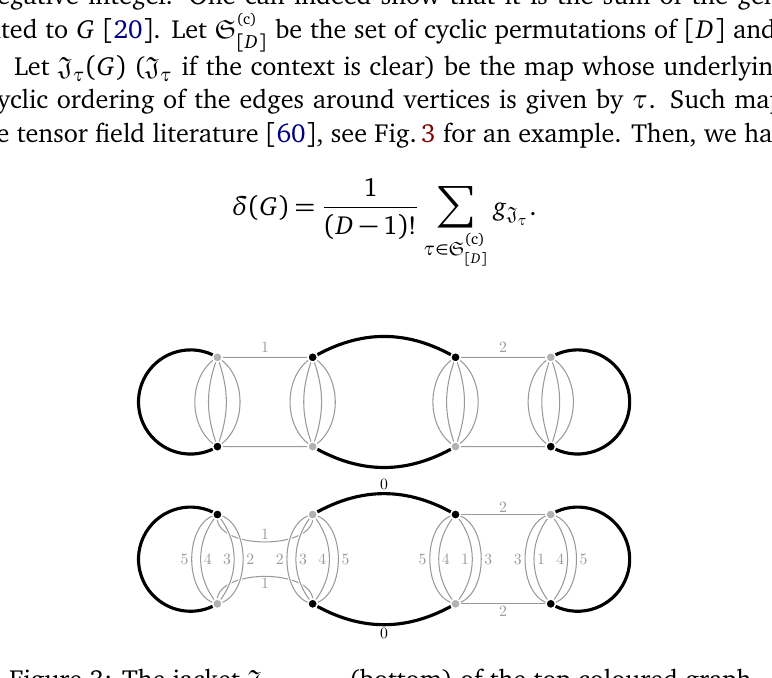
(bottom) of the top coloured 023145 )